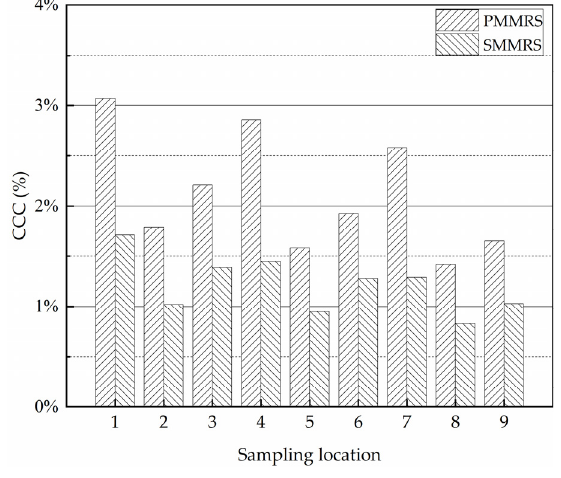
Figure 7. CCC test results of PMMRS and SMMRS in different sampling locations. The average CCC for the specimen was used to study the relationship between the CCC in specimens and the CaCl 2 concentration in cementation solution. The calcium ions conversion rate was adopted to evaluate the efficiency of MICP process, which can be calculated by Equations (9) and (10). The results of average CCC and calcium ions conversion rate ( CICR ) in different specimens are shown in Figure 8.